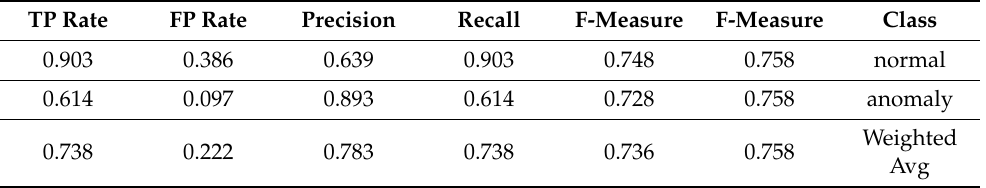
Figure 6. SMO result using a dataset with 22 attributes. Table 3. Demonstrate details of accuracy parameters for SMO.